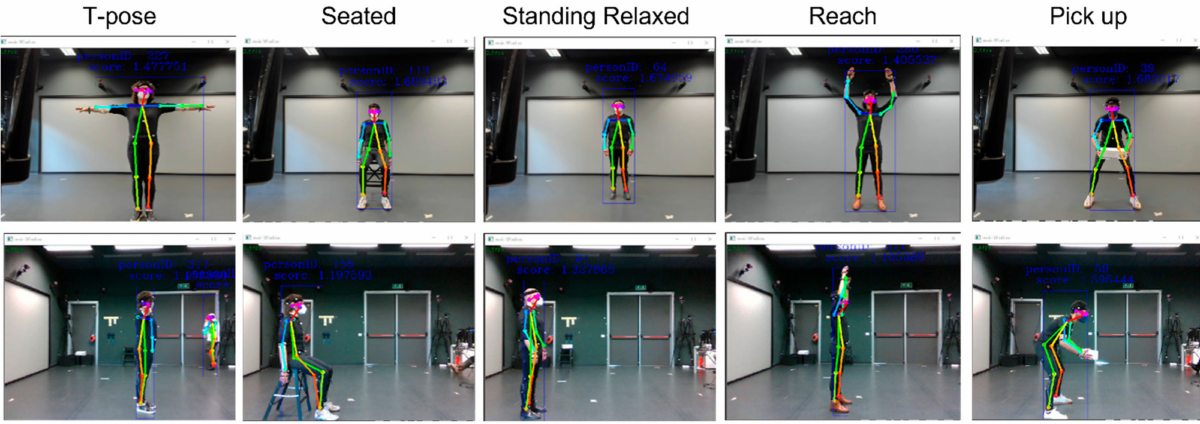
Figure 6. Graph comparing the RMSE values “RGB-MAS vs. manual” and “Vicon vs. manual”.